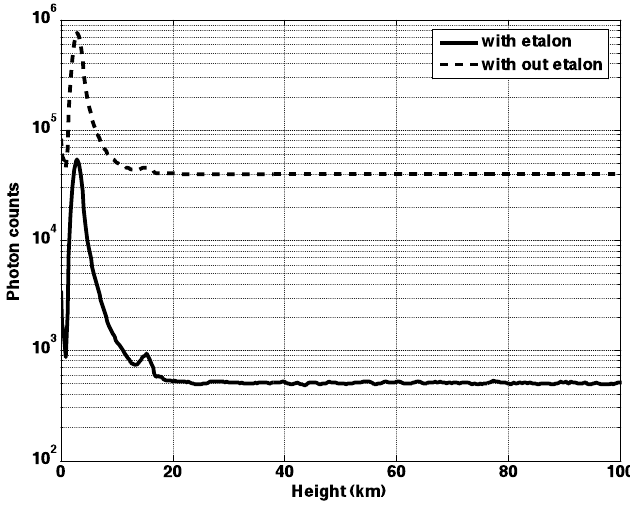
Figure 3. Raw data without the range correction, collected on March 4, 2010, at 0700 LT. The cloud presence is clearly visible in the 'with etalon